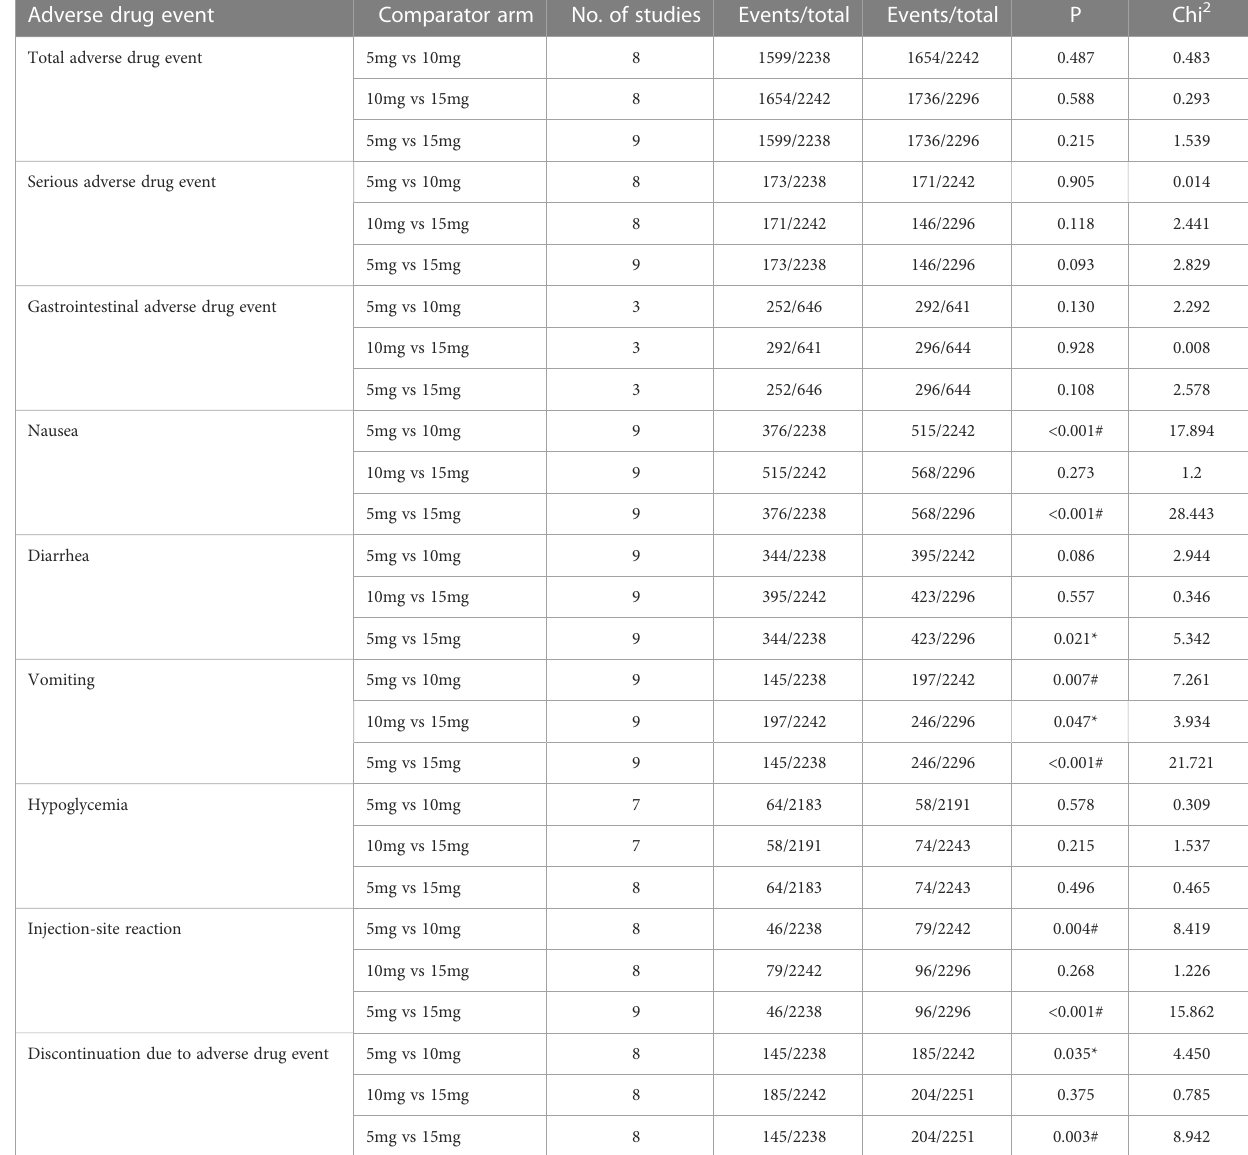
TABLE 2 Chi-square analysis results of different doses of Tirzepatide for adverse drug event. Adverse drug